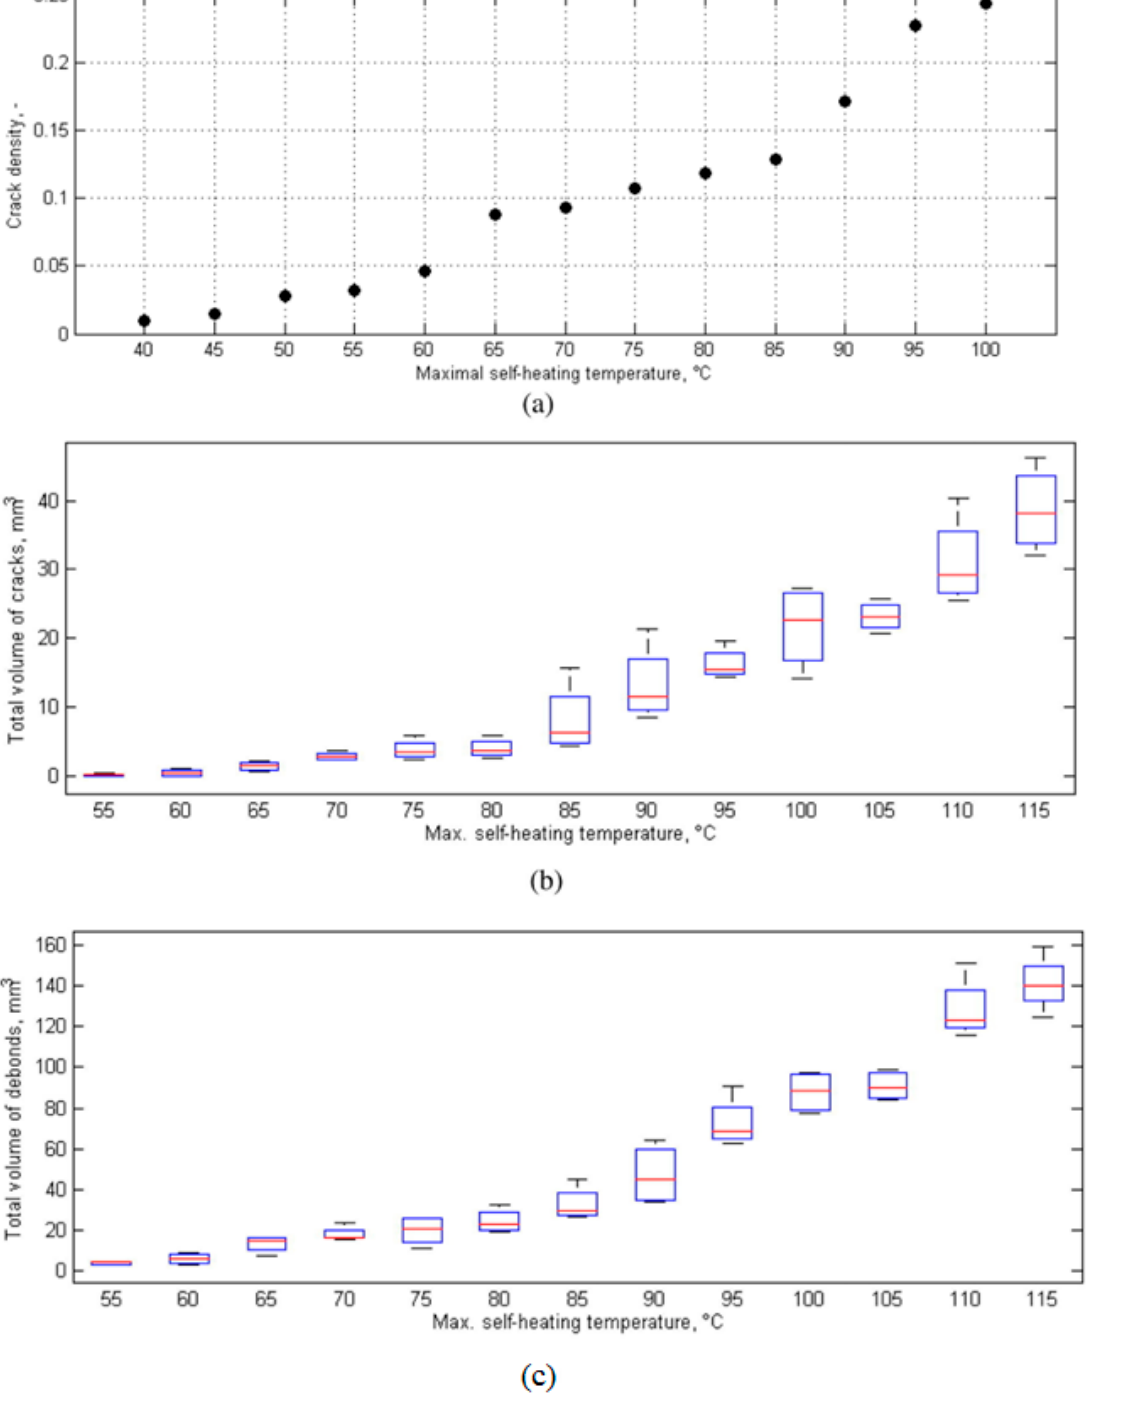
Figure 44. ( a ) Crack density [1], ( b ) total volume of cracks and ( c ) total volume of debonds induced by fatigue loading dominated by self-heating temperature, adapted with permission from Ref.